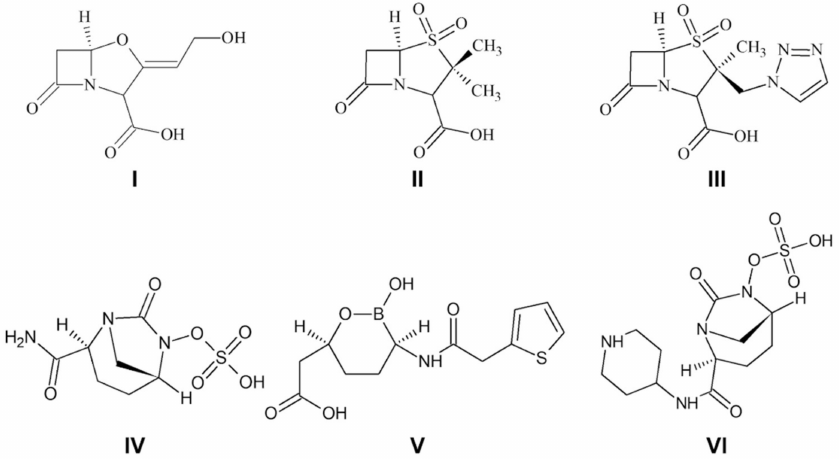
Figure 1. Structure of clinically available BLIs: clavulanic acid ( I ), sulbactam ( II ), tazobactam ( III ), avibactam ( IV ), vaborbactam ( V ), relebactam ( VI